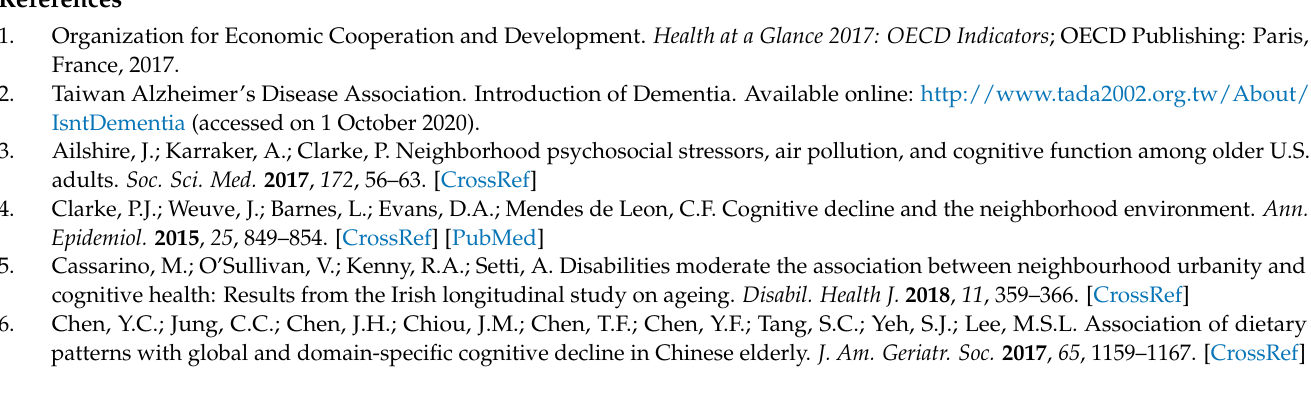
Table S2. Cluster analysis of dietary patterns; Supplementary Table S3. Cognitive function associ- ated with city- and individual-level for older adults in Taiwan 2013–2016 by mixed-effect model (categorical population